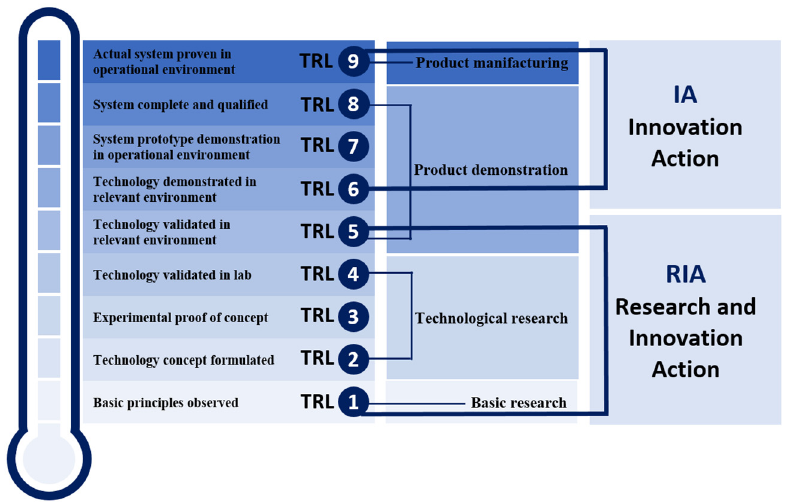
Figure 1. Technology Readiness Level definition.